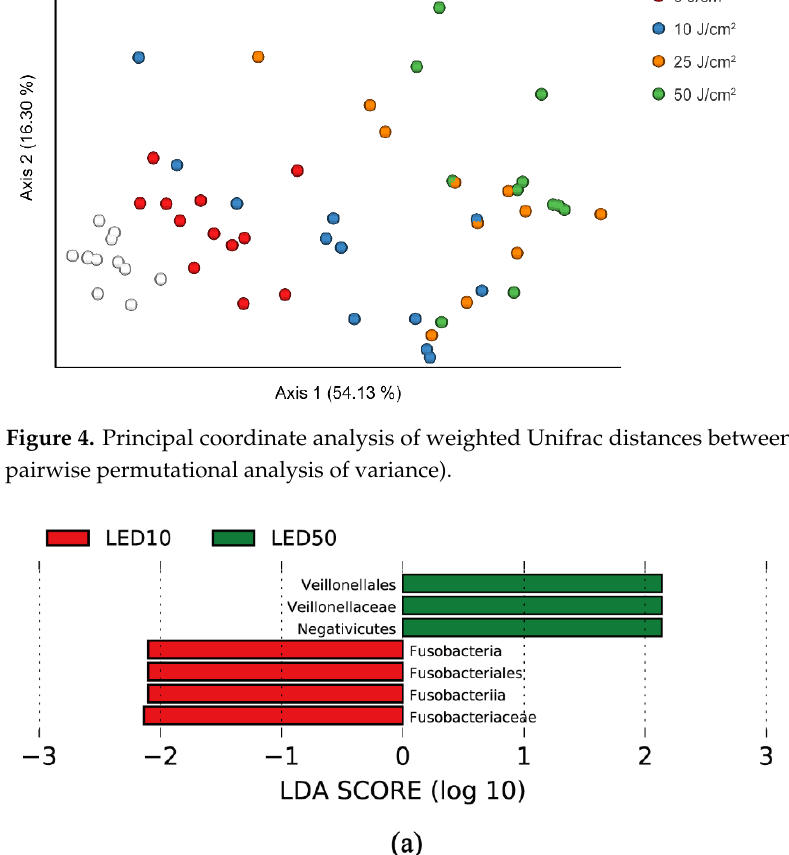
Figure 5. Linear discriminant analysis effect size identification of the most differentially abundant taxa between plaque microbiotas with 10 J/cm 2 and 50 J/cm 2 of violet LED irradiation. ( a ) Histogram of linear discriminant analysis scores (log10) computed for features with differential abundance in samples exposed to 10 J/cm 2 and 50 J/cm 2 of violet LED irradiation (red, 10 J/cm 2 ; green, 50 J/cm 2 ). ( b ) Taxonomic representation of statistically and biologically consistent differences in samples ex- posed to 10 J/cm 2 and 50 J/cm 2 of violet LED irradiation. Each filled circle represents a phylotype. The name of phylum and class are indicated on the cladogram, with the order or family given in the panel below. The diameter of each circle is proportional to the taxon abundance. 2.3. Violet LED Irradiation Shifts the Relative Abundance of Specific Oral Bacteria The present results suggest that interdental plaque is a composition of oral bacteria with violet LED sensitivities. As shown in Figure 6, six operational taxonomic units (OTUs) with statistically significant differences were identified using the Wilcoxon rank- sum test through the analysis of the samples collected from 12 subjects. The relative pro- portions of Fusobacterium sp. decreased, whereas the relative abundance of Streptococcus sp., Veillonella sp. , Veillonella dispar, Veillonella parvula, and Campylobacter concisus increased with the irradiation dose of violet LED light. As for the genus Fusobacterium , F. nucleatum subsp. animalis , F. nucleatum subsp. vincentii , and F. periodonticum were significantly de- creased according to Fisher’s exact test (Table S1). In fact, as shown in Figure 7a, when irradiated with violet LED light, the cultured F. nucleatum subsp. polymorphum exhibited a significantly decreased colony forming unit (CFU) count. In contrast, cultured V. parvula